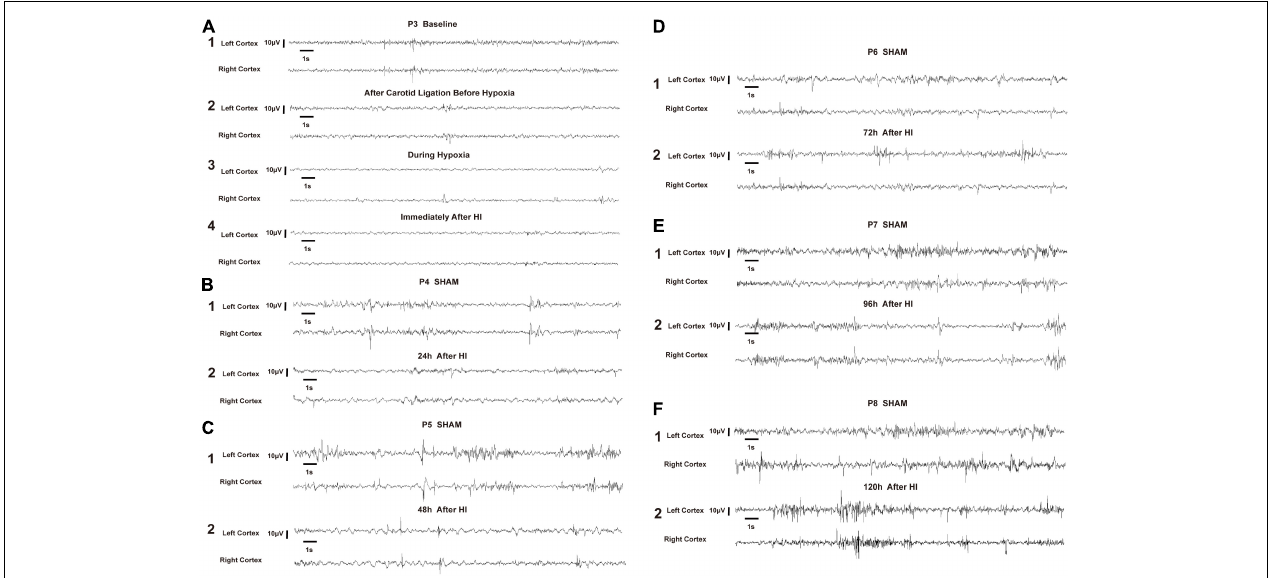
FIGURE 5 | Representative electroencephalography (EEG) of hypoxia–ischemia (HI) group and sham control group. All representative EEG epochs were acquired in the neonatal rats during quiet state to minimize the artifact. The overall voltage of EEG after left carotid artery ligation and before hypoxia (A2) showed a decreasing trend compared to the P3 baseline (A1) . During the HI induction (A3) and immediately after hypoxia (A4) , the voltage of EEG were significantly lower than baseline (A1) . The voltage gradually recovered at 24 h and 48 h after HI induction, but was still lower than that of P4 and P5 in the sham group, respectively (B,C) . The EEG voltage at 72 h, 96 h and 120 h after HI induction gradually returned to the level of the sham group at P6, P7 and P8, respectively, and the EEG wave was more continuous (D–F) . EEG was acquired in a P3 rat in the HI group during the baseline (A1) , after left carotid ligation, but before hypoxia (A2) , during hypoxia (A3) , immediately after HI (A4) , 24 h after HI (B2) , 48 h after HI (C2) , 72 h after HI (D2) , 96 h after HI (E2) , and 120 h after HI (F2) . In the sham group, EEG was acquired from P4 (B1) , P5 (C1) , P6 (D1) , P7 (E1) , and P8 (F1) . V, volts, S,